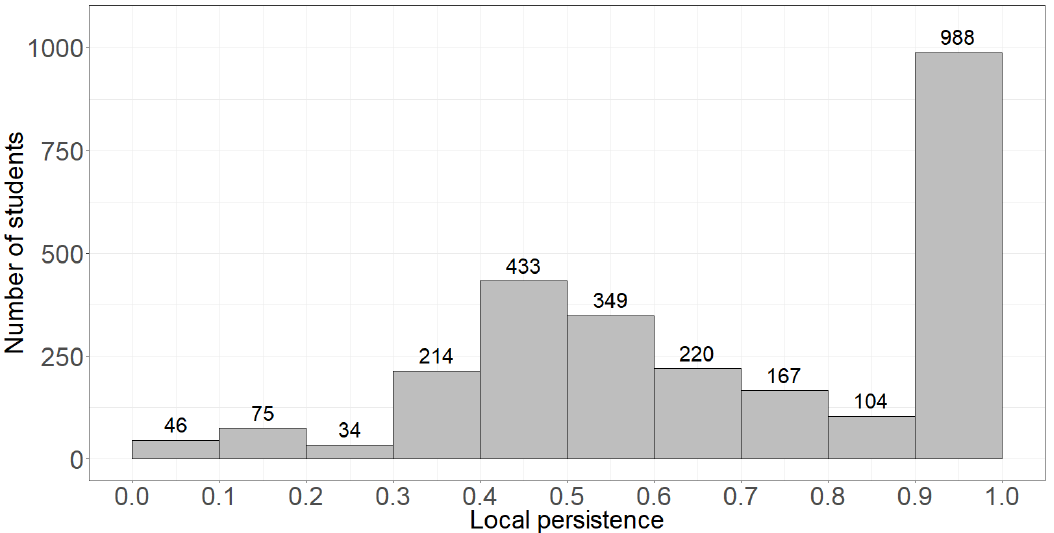
Figure 1. Histogram with the prevalence of the local persistence.